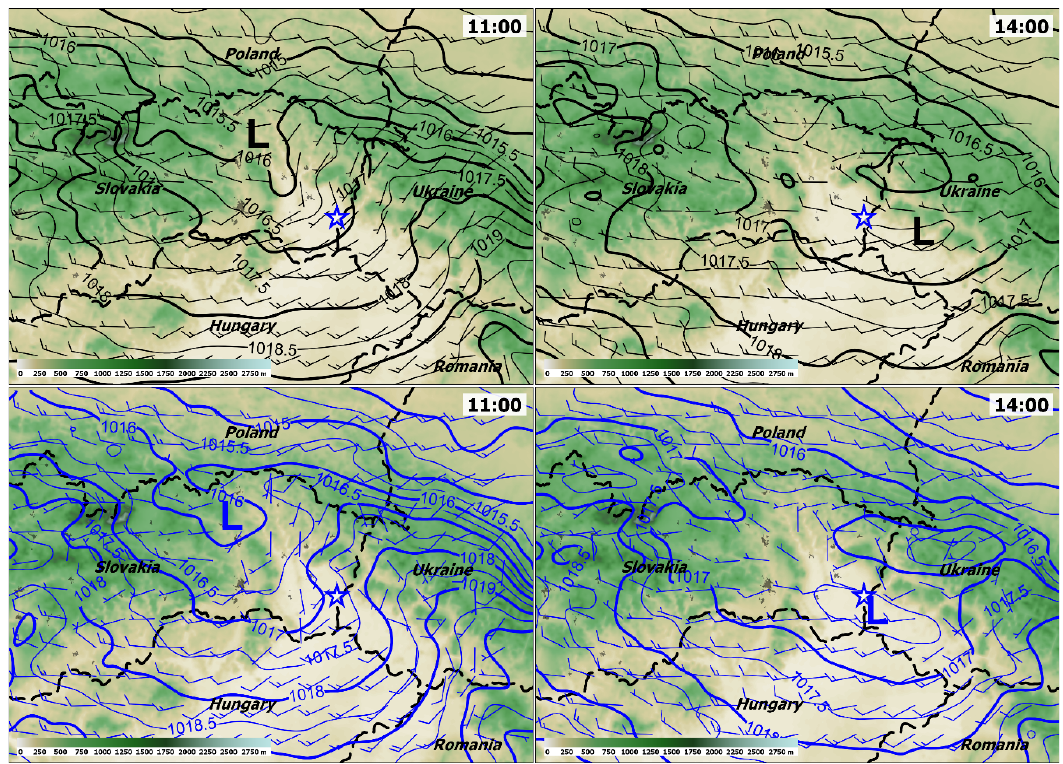
Figure 12. Model-run forecast on 3 October 2018 06:00 UTC for 11:00 and 14:00 UTC mean sea-level pressure and surface winds over eastern Slovakia based on NWP OPM (black) and ELAM (blue). Center of shallow trough/low marked by “L”. Country names shown in italics. Tornado occurred at 14:30 UTC; its location is highlighted by blue star. Atmosphere 2020 , 11 , x FOR PEER REVIEW 12 of 16